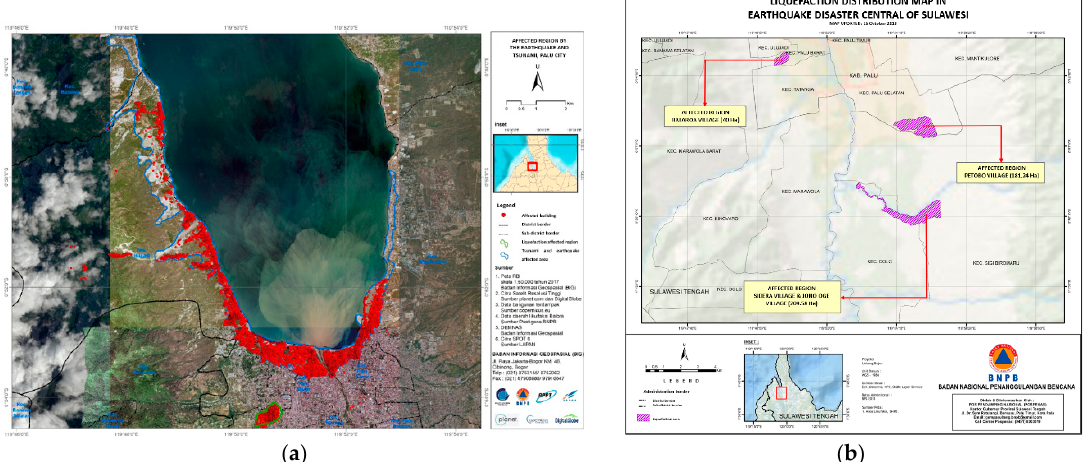
Figure 13. Field data from the National Board for Disaster Management of Indonesia: ( a ) the region affected by the earthquake and tsunami in Palu, Indonesia, on 28 September 2018; ( b ) liquefaction distribution map. Modified from [1].